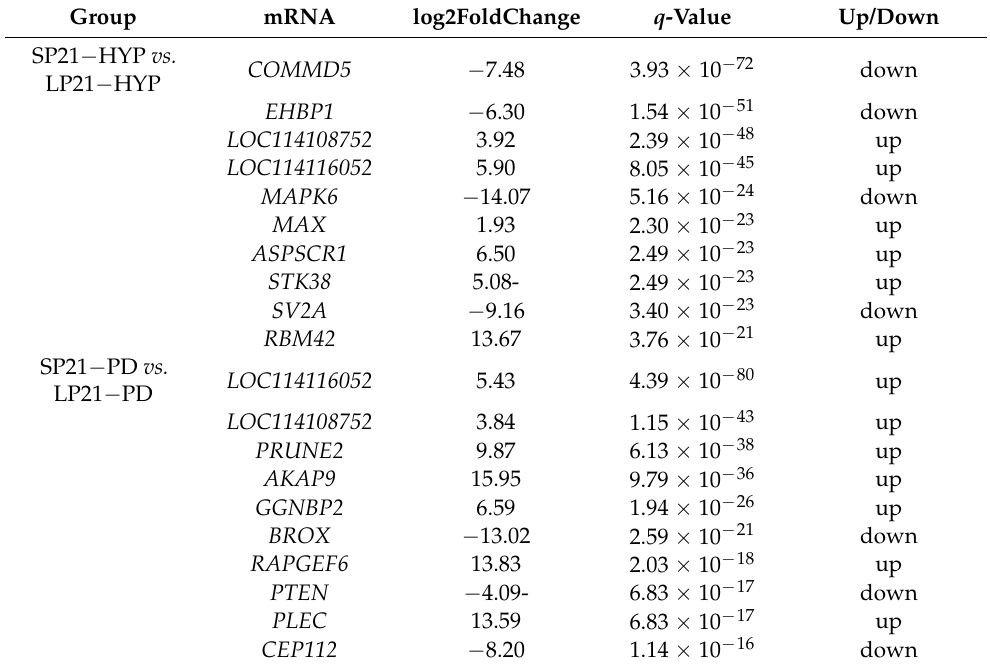
Table 3. mRNAs with the Most Significant Differences in Expression of Hypothalamus and Distal Pituitary. Group mRNA log2FoldChange q -Value Up/Down SP21 − HYP vs. LP21 − HYP